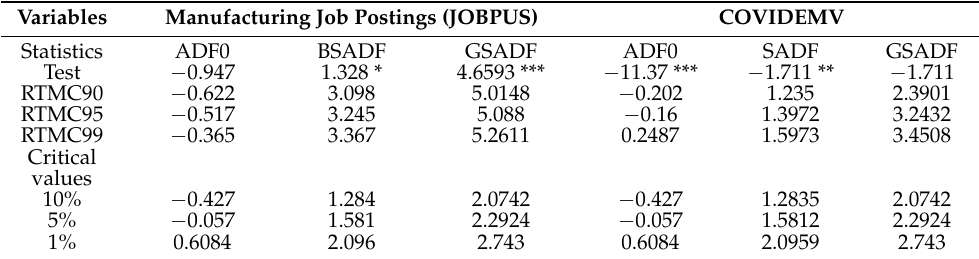
Table 3. Results of BSADF unit root tests with explosive